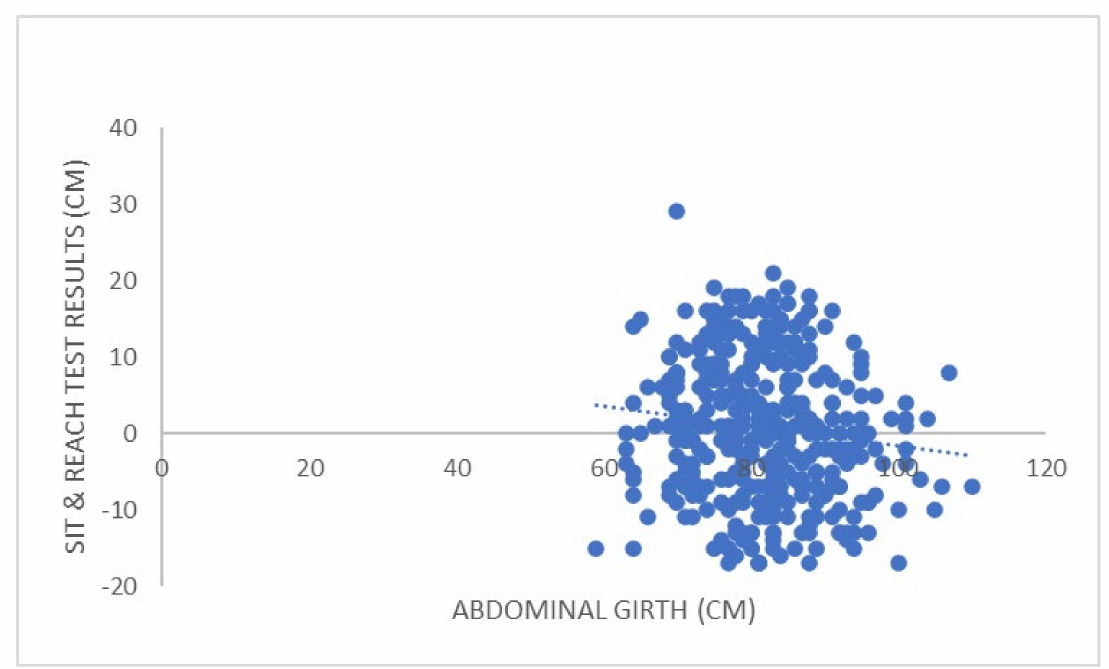
Figure 1. Correlation between the results obtained by the study participants in the sit-and-reach test and abdominal girth (the only parameter with which maintained a statistically significant correlation).